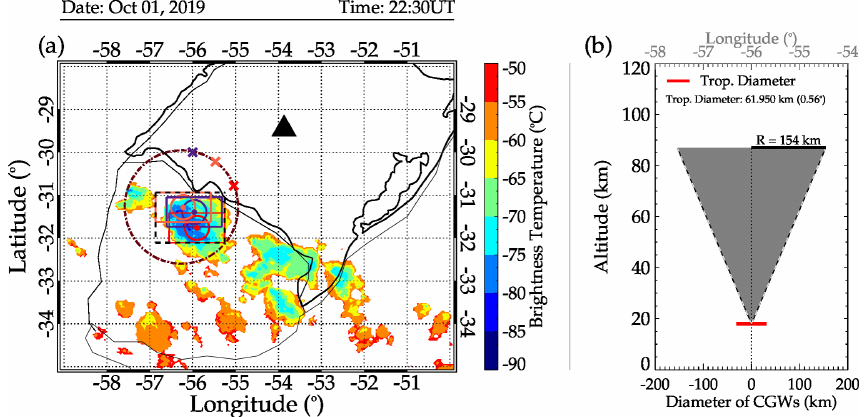
Figure 9. A pictorial description of how the regions of overshooting convective cores were considered to determine the overshooting tops tracked in space and